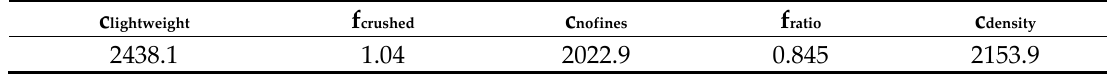
Table 3. Optimized model